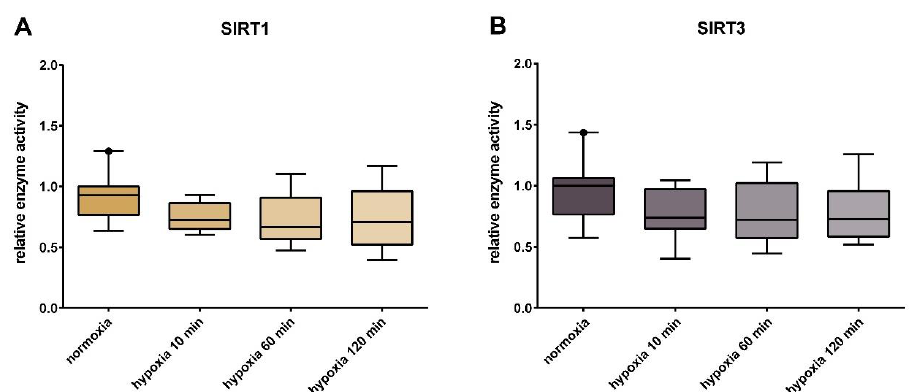
Figure 3. Relative sirtuin enzyme capacity in the HUVECs. Relative maximum activity of SIRT1 ( A ) and SIRT3 ( B ) in the HUVECs. Normoxic controls were compared with cells incubated under hypoxia for 10, 60, and 120 min. Shown are the median, upper, and lower quartile, and the 5% and 95% percentile. Each group had a sample size of n = 3. Normoxic SIRT1 enzyme capacity averaged 1.8 U / 10,000 cells in the normoxic HUVECs. The normoxic enzyme activity of SIRT3, averaged 9.5 U / µ g protein. In all cell lines, we observed an upward trend of NAD + levels, at incubation times of 10 min and 60 min under hypoxic conditions. A significant increase of 57% (± 0.19% SD) was observed after an incubation time of 120 min, under hypoxia (Figure 4). Figure 4. Intracellular NAD + concentration in the HUVECs. The normoxic controls were compared with the cells incubated under hypoxia for 10, 60, and 120 min. The NAD + concentration is presented in mM. Shown are the median, upper, and lower quartile, as well as the 5% and 95% percentile. Each group had a sample size of n = 3. Significance: * p < 0.05. 4. Discussion Cardiovascular diseases are often associated with endothelial dysfunction, such as impaired eNOS activity and diminished NO bioavailability. The pathophysiological processes underlying this phenomenon are incompletely understood [71,72]. Hypoxia might contribute to hampered endothelial function and downregulation of energy metabolism. Sirtuins are important regulatory elements of energy metabolism and antioxidative defense, using post-translational modifications [32,52,73,74]. Sirtuins were recently shown to regulate vascular and especially endothelial functions, under physiological conditions [1–4]. Dysregulation of sirtuins was observed under